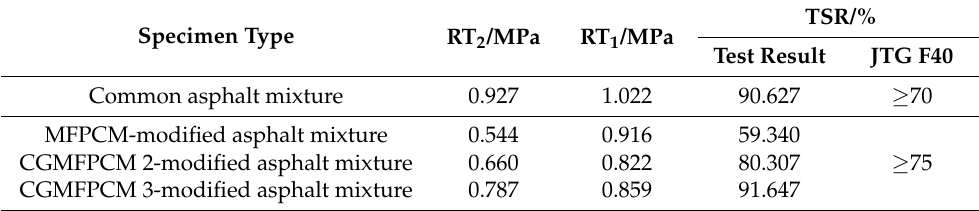
Table 12. Freeze–thaw splitting test results for common and modified asphalt mixtures.